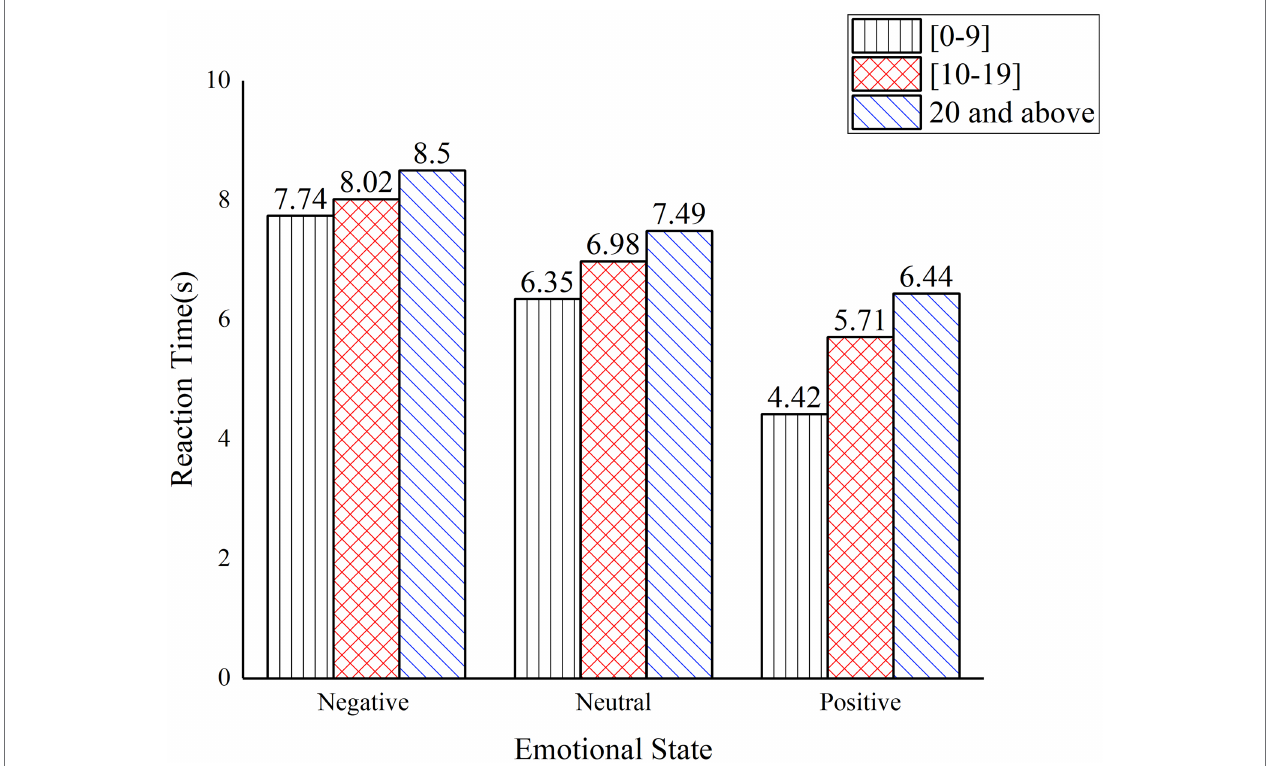
FIGURE 6 | Reaction time to safety hazard under different working ages. TABLE 9 | One-way ANOVA results for identification accuracy at different working ages. Emotional Working states